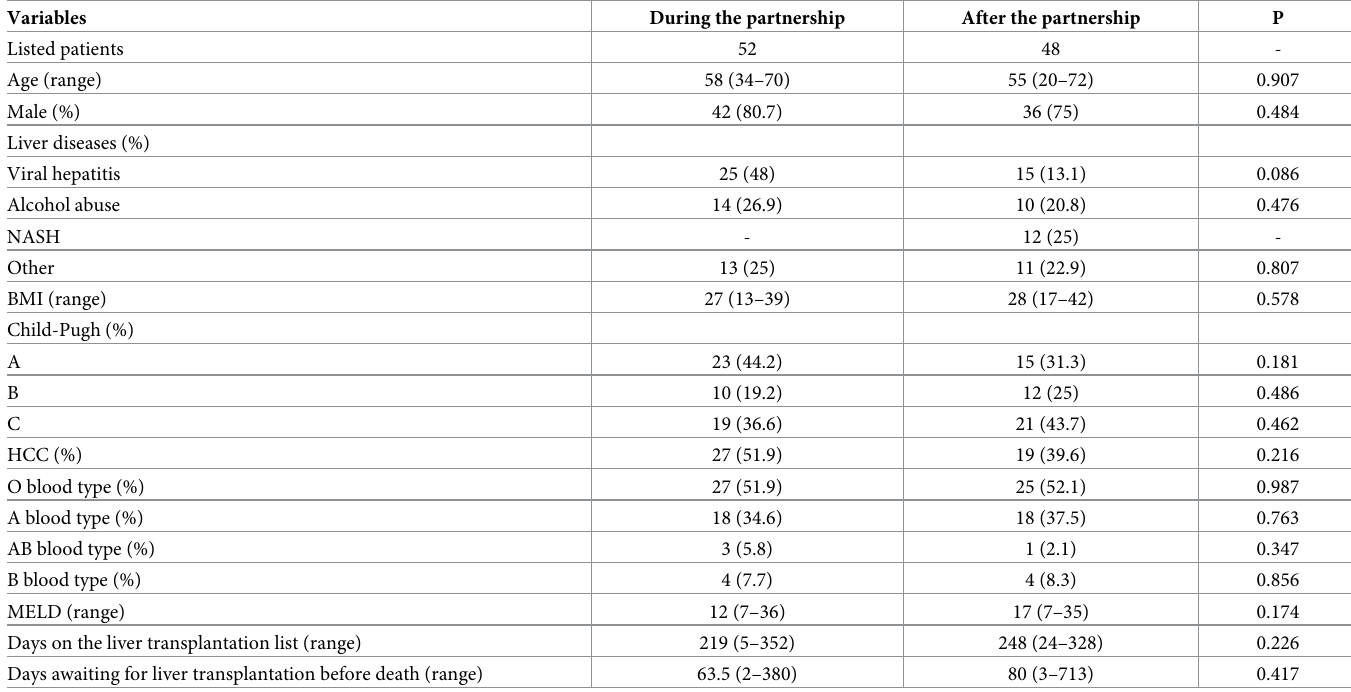
Table 1. Characteristics of the transplant patients at the new center during and after the